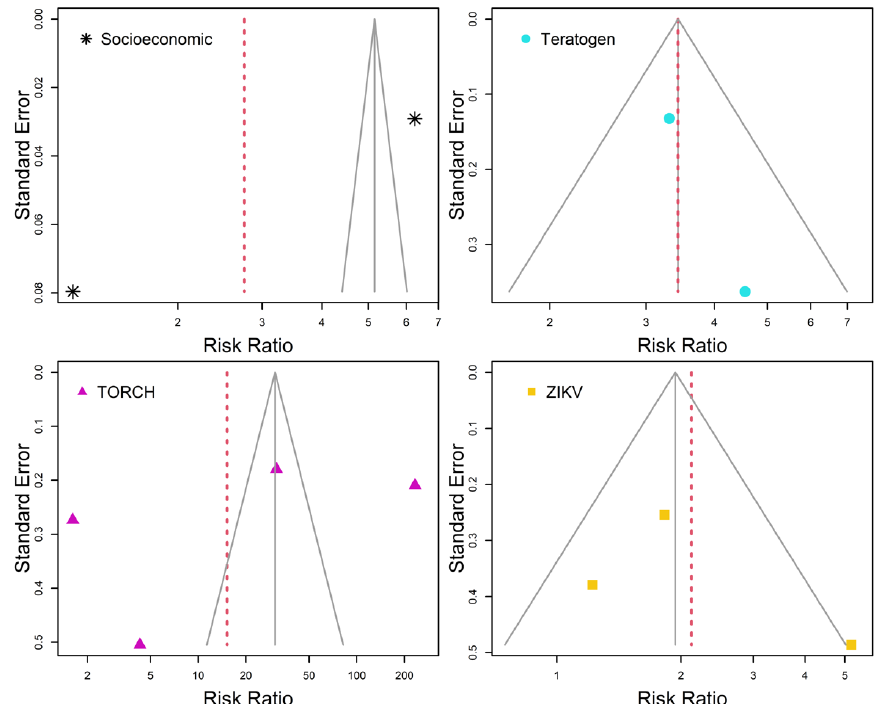
Figure 3. Funnel plots of individual study risk ratio and standard error per risk factors. Solid gray lines are referred to the common effect model. Random effects model estimates are highlighted by dashed red lines. Absence of publication bias occurs when all individual study results are contained within the solid gray lines.